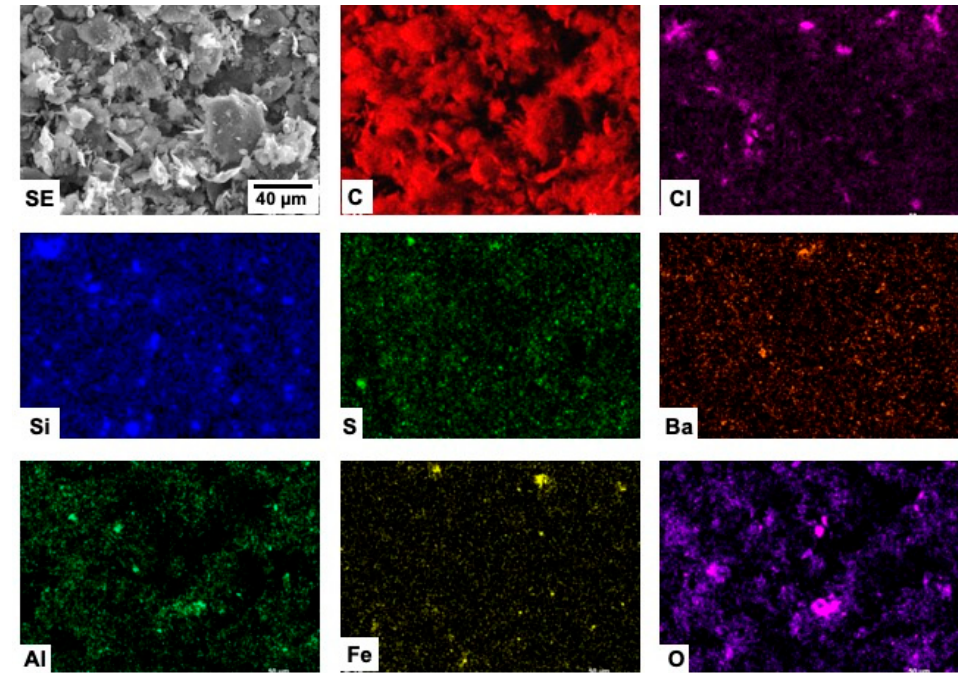
Figure 4. SEM-EDX mappings from sample C-BBM.